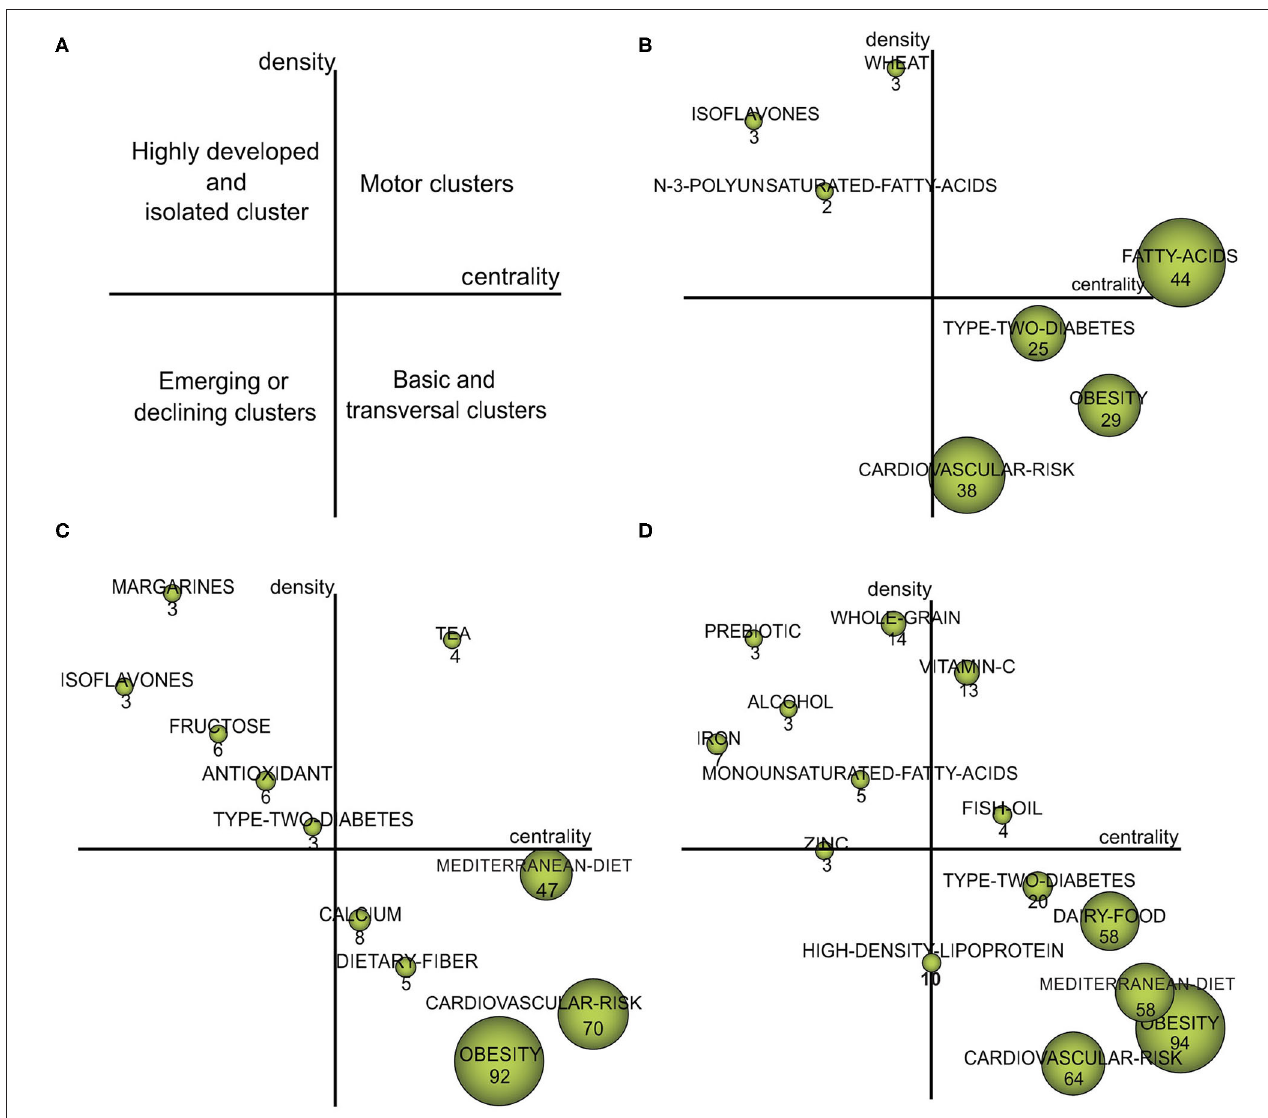
FIGURE 7 | Strategic diagrams for dietary factors of MetS. (A) The interpretation of the strategic diagram; (B) Strategic diagram of dietary factors of MetS from 2000 to 2009; (C) Strategic diagram of dietary factors of MetS from 2010 to 2014; (D) Strategic diagram of dietary factors of MetS from 2015 to